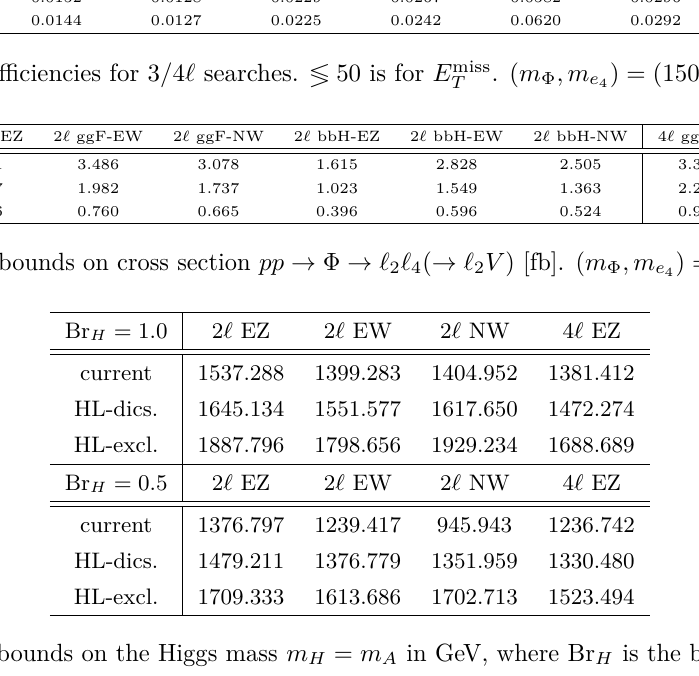
= 750 GeV, tan β = 10 . 4